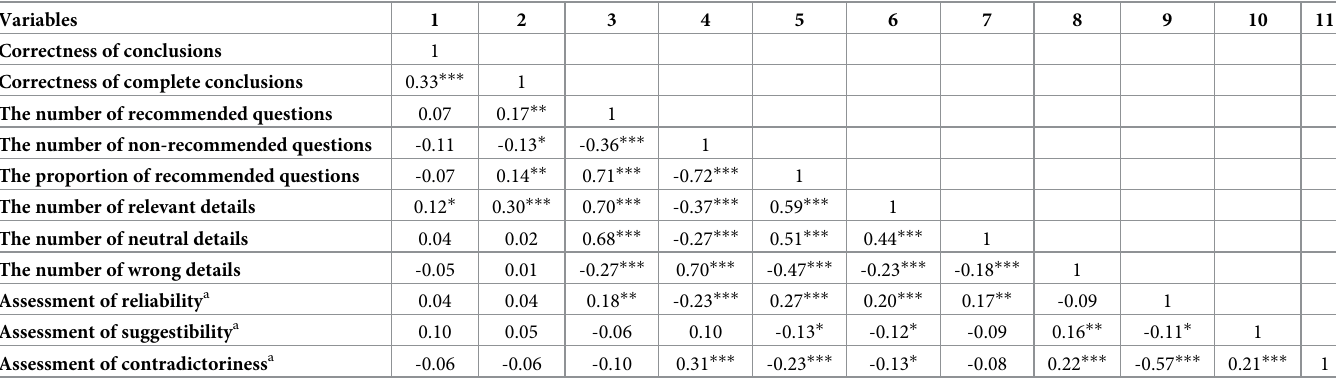
Table 10. b Within-subject correlations between correctness of conclusions, types of questions, types of details, and assessment of